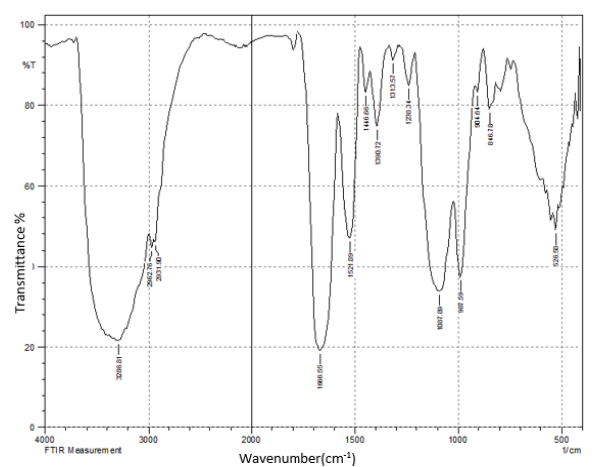
Figure 1. UV-Vis spectroscopy absorbance of Nigella sativa seeds silver nanoparticles made from AgNO with Nigella sativa extract in pH 5.5